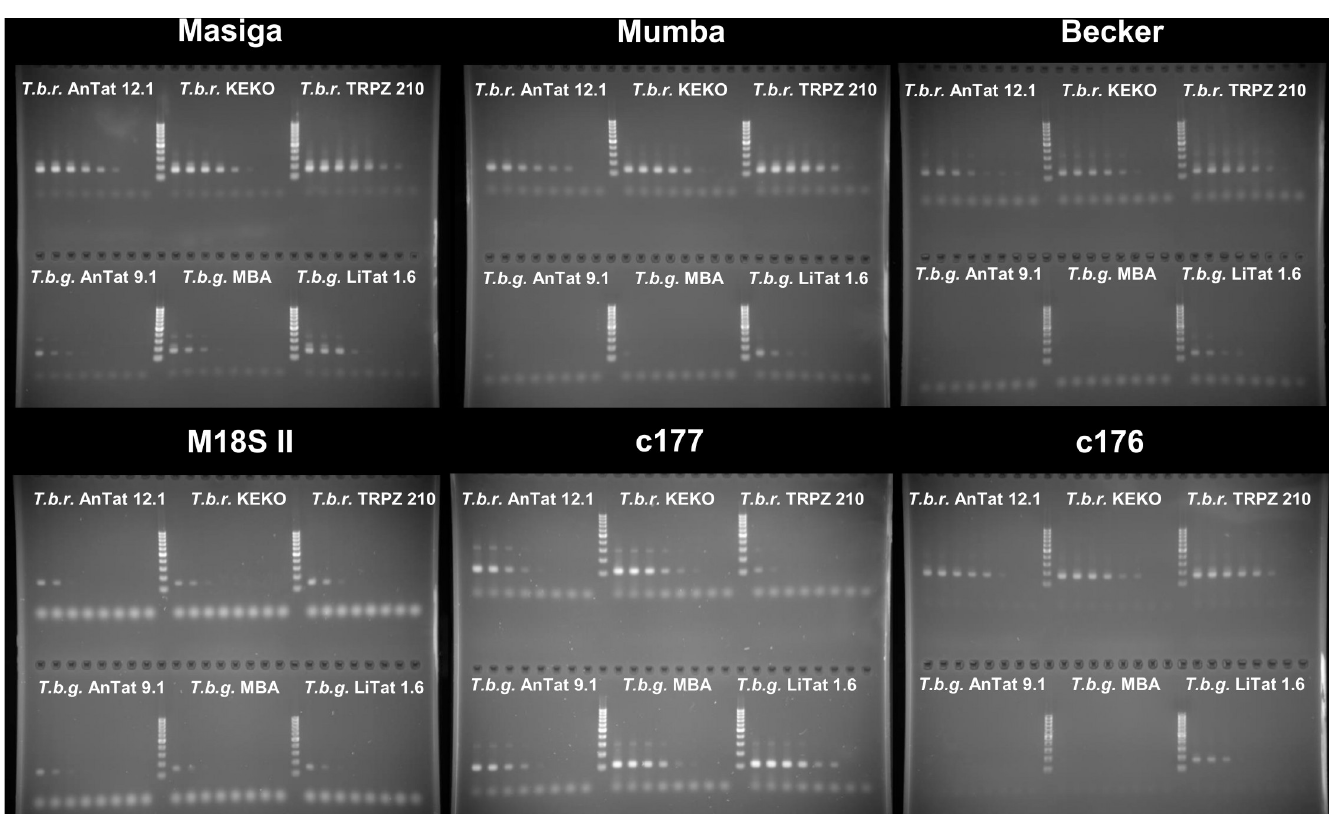
Fig 2. Semi-quantitative conventional TBR PCRs on Trypanozoon . Semi-quantitative conventional TBR PCRs using the c177, c176, Masiga, Becker, Mumba, and M18S II primer sets on fivefold serial dilutions containing 2000, 400, 80, 16, 3.2, 0.64, 0.128 or 0 fg of pure genomic Trypanozoon DNA. Each of the six gels shows the electrophoretic results of one conventional PCR tested on 3 T . b . r .(upper part of the gels) and 3 T . b . g .(lower part of the gels) strains, separated by 5 μ l of the Generuler 100-bp DNA ladder (Thermo Scientific). https://doi.org/10.1371/journal.pone.0258711.g002 varied greatly between and even within the different Trypanozoon taxa (Fig 3). The 177-bp TBR group, assayed using q177 and q177 had RCNs ranging from tens to hundredths for D T most Trypanozoon , including T . b . g . I, and up to thousands in the case of T . ev . /eq . A. In